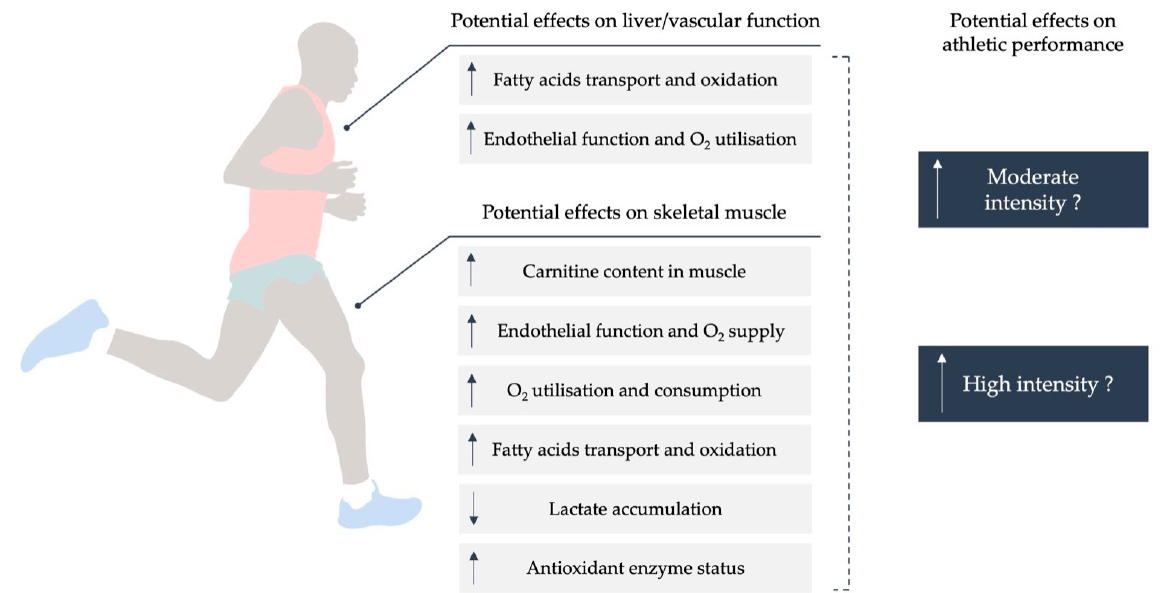
Figure 1. Potential effects of L -Carnitine supplementation on different physiological and metabolic pathways that could improve moderate- and high-intensity exercise performance.